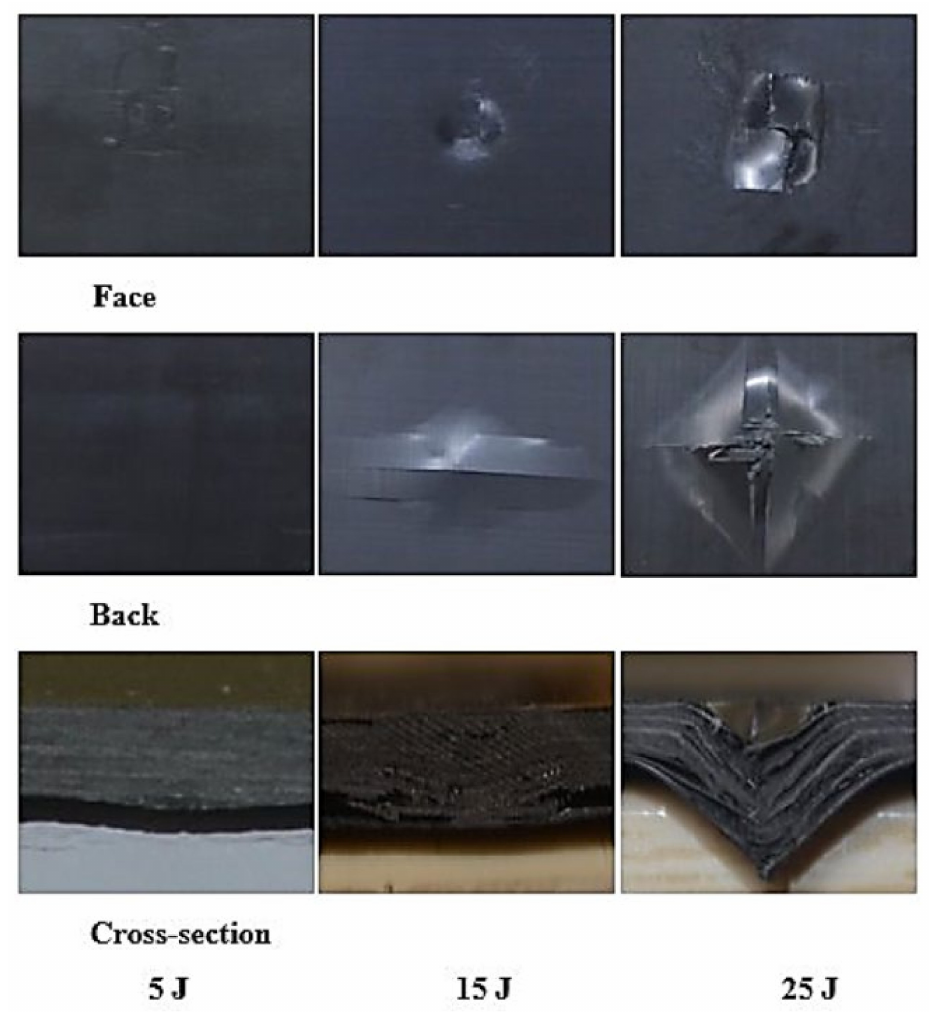
Figure 11. Pictures of the top and bottom surfaces and cross-sectional view of [A/A] at 5, 15, and 25